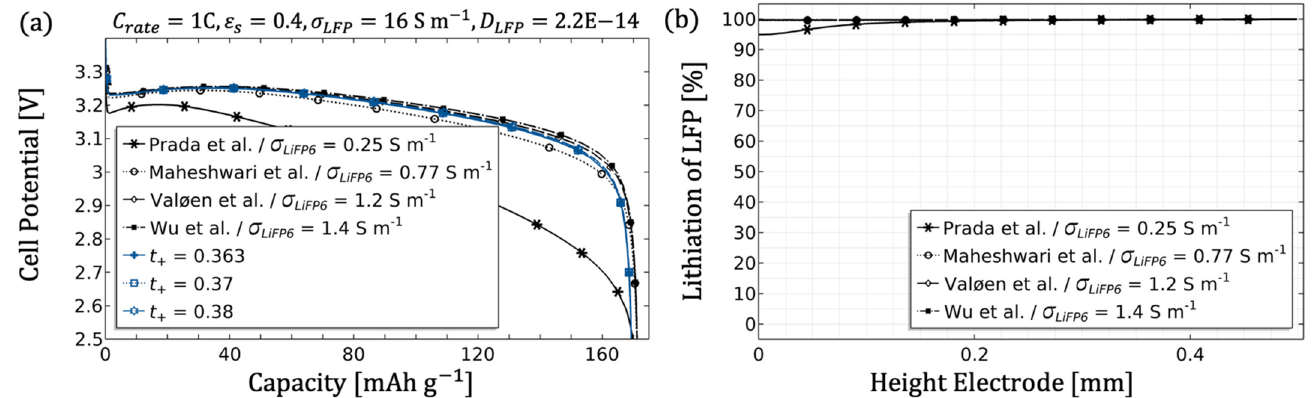
Figure 9. Parameter variation of the electrolyte conductivity prefactor σ LiPF 6 correlated to the reported values of σ l at 1 M and 298 K as well as the variation of the transport number t + ; ( a ) shows the discharge performance and ( b ) the lithiation at a DoD = 1.